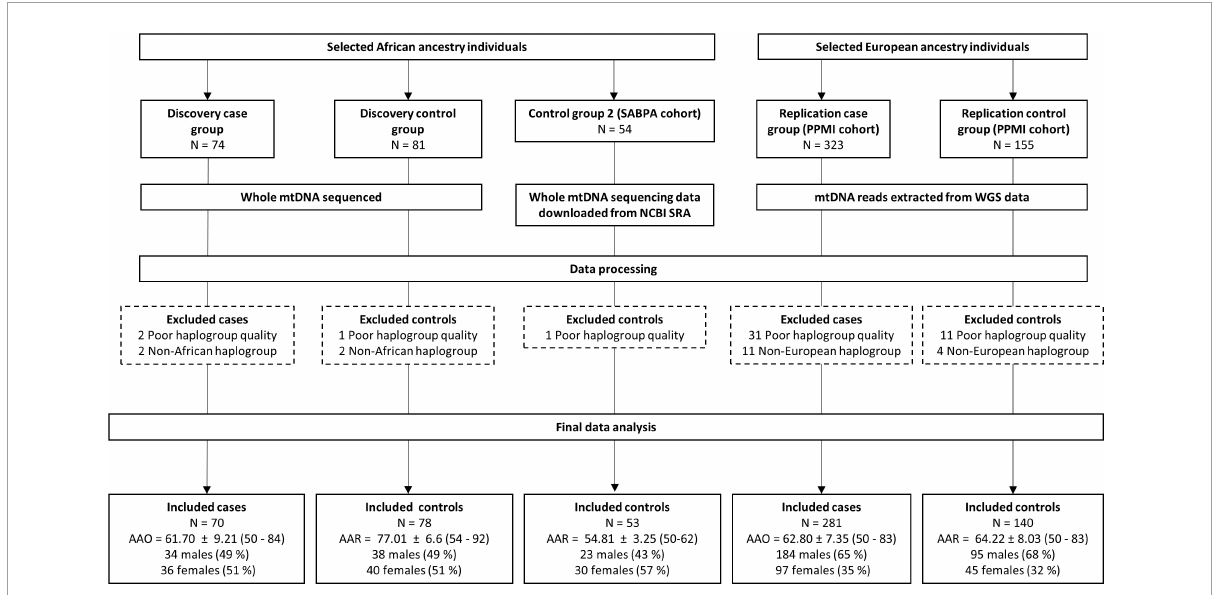
FIGURE1 Flow diagram showing the number of African and European ancestry PD cases and controls from each group initially selected for this study, as well as the demographics of the individuals included in the final data analysis. AAO, age at onset; AAR, age at recruitment; mtDNA, mitochondrial DNA; NCBI, The National Center for Biotechnology Information; PPMI, Parkinson’s Progression Markers Initiative; SABPA, Sympathetic activity and Ambulatory Blood Pressure in Africans Study; SRA, Sequence Read Archive; WGS, whole genome